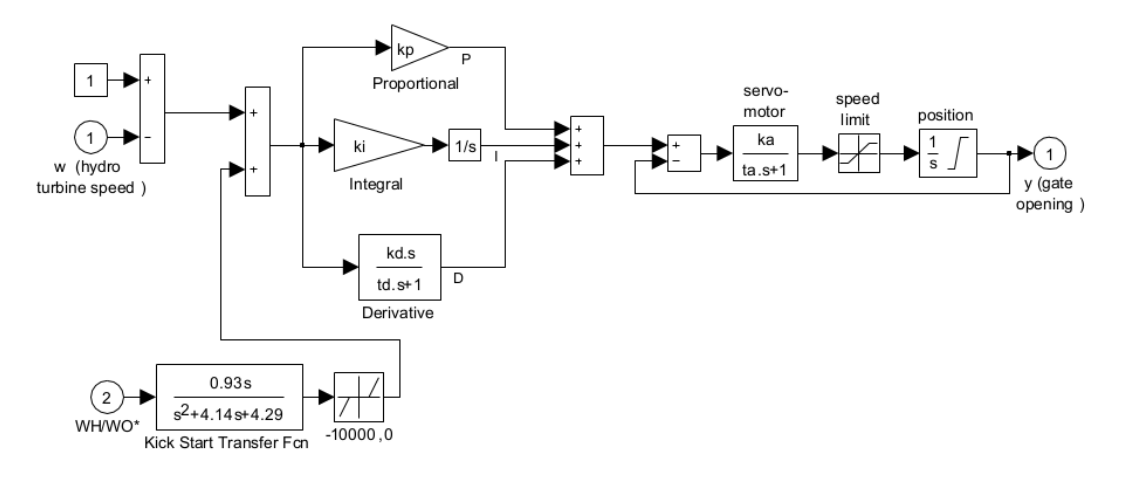
Figure 5. Hydraulic turbine speed governor Simulink schematics.